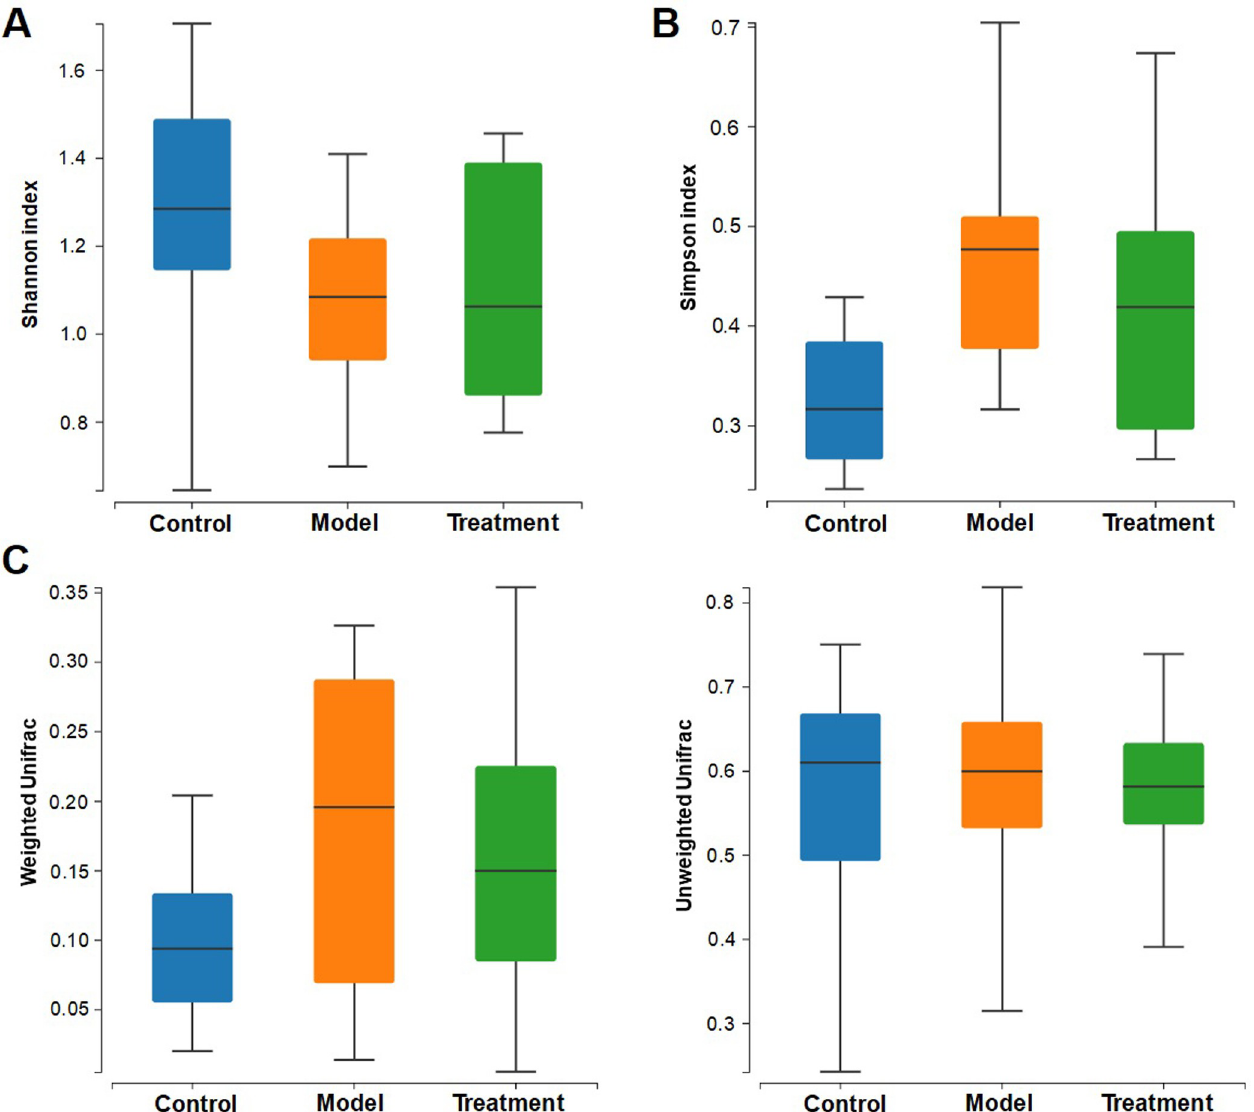
Fig 2. Influence of the MMWA treatment on gut microbiota diversity. (A) Shannon index. (B) Simpson index. (C) Beta diversity of gut microbiota.